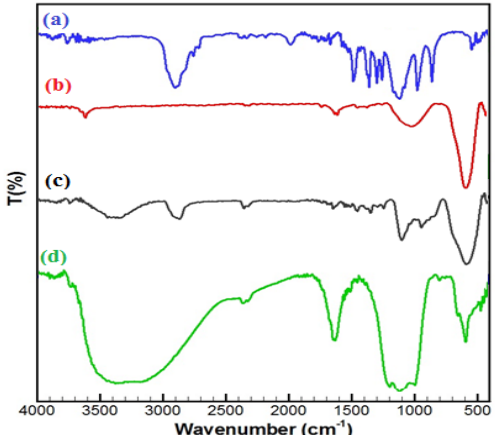
Fig. 1. The FT-IR spectra of (a) PEO, (b) CuFe